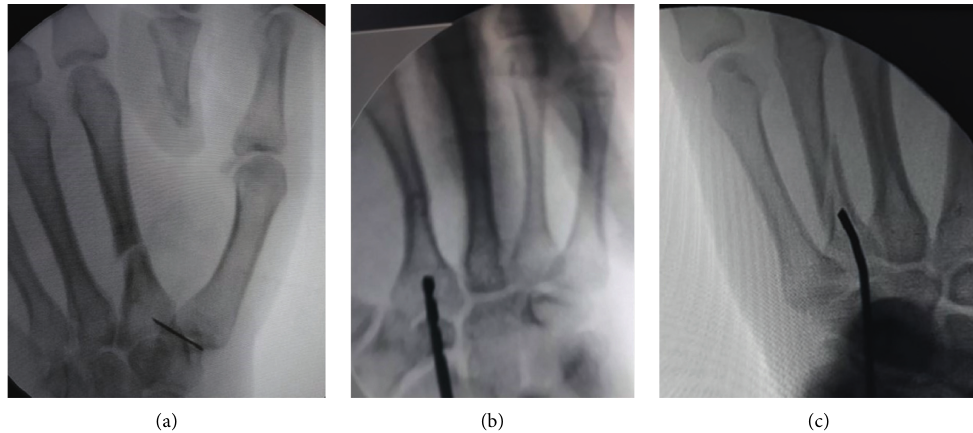
Figure 2: (a) Fluoroscopic photo showing the identification of the incision site by a syringe needle. (b) Fluoroscopic photo for antegrade fixation of a fracture of the second metacarpal shaft. A 2.5 drill bit is used for drilling of the dorsal cortex. (c) Fluoroscopic photo shows the advancement of the blunt-tipped prebent K-wire through the entry hole in the dorsal cortex.